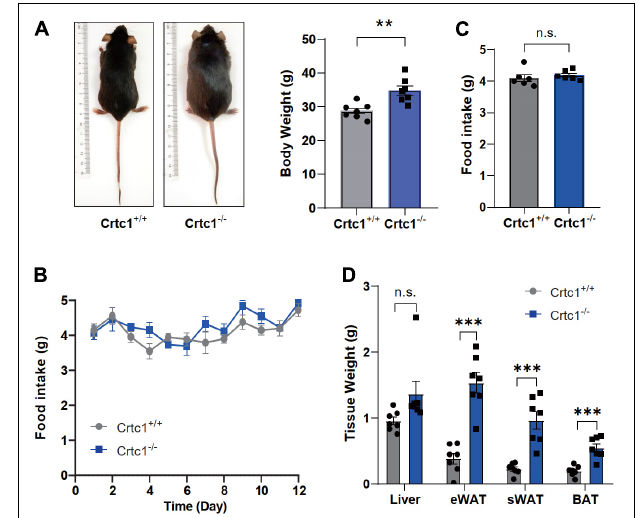
FIGURE 1 | Construction of the Crtc1 knockout (Crtc1 − / − ) mouse. (A) Schematic diagram of knocking out Crtc1 gene using CRISPR/Cas9 system. (B) The mRNA level of Crtc1 was detected by agarose gel